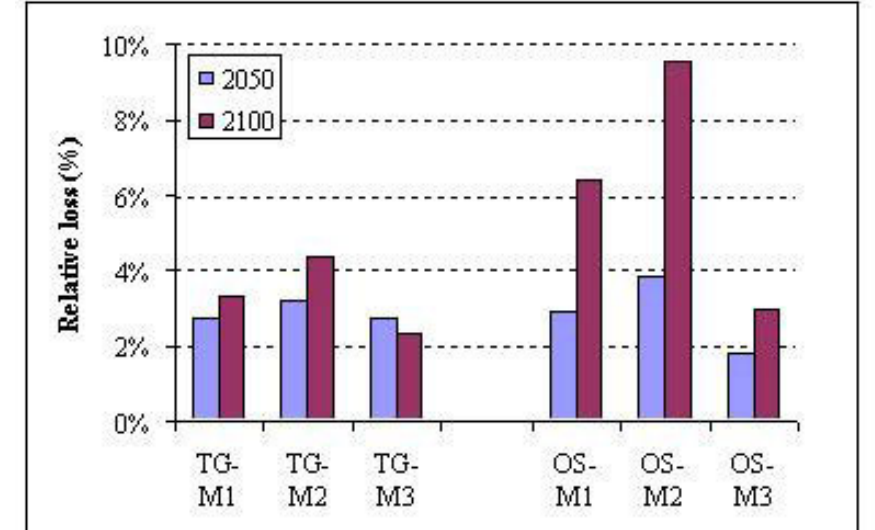
Figure A1.1. Biodiversity loss at equilibrium in 2050 and 2100 for the TechnoGarden (TG) and Order from Strength (OS) Scenario three different methods explored for assessing the impacts of climate change. M1 represents our default method, while M2 assumes no adaptation and M3 full